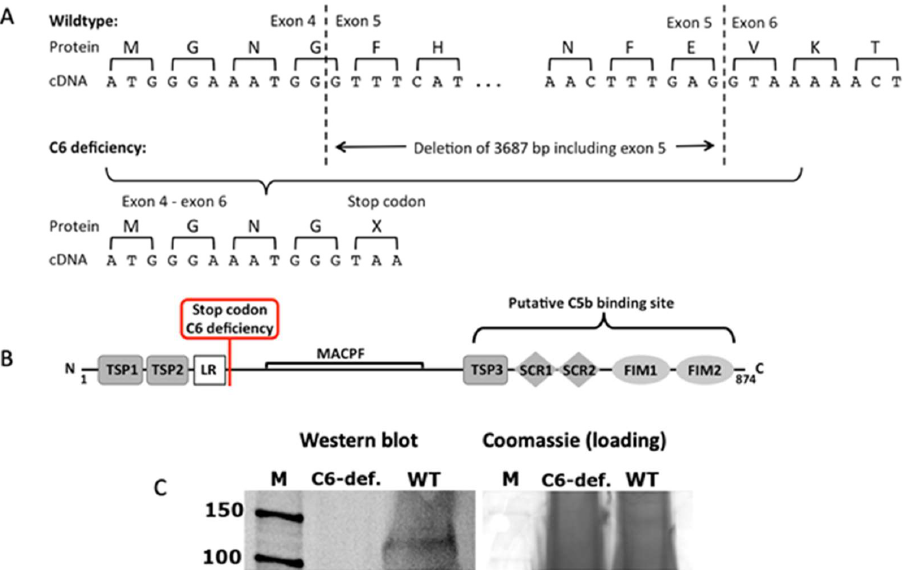
Figure 1: Characterization of the mutated C6 gene. ( A–B ) Structure of the rabbit C6 protein accord- ing to transcript C6-201, ENSOCUT00000001933 (Ensemble release 84) with indication of the puta- tive C5b binding site 2 and the stop codon caused by the mutation; TSP: thrombospondin type 1 repeat, LR: Low-density lipoprotein receptor class A repeat, MACPF: Membrane attack complex component/perforin domain, SCR: short consensus repeats, FIM: factor I modul. ( C ) Consequence of the genomic deletion in the C6 gene of C6-deficient rabbits on protein level. Serum of C6-deficient (C6-def.) and wildtype rabbits (WT) was resolved by 12% SDS-PAGE and coomassie-stained or used for western blot and detected with a C6-specific antibody; M: protein marker.